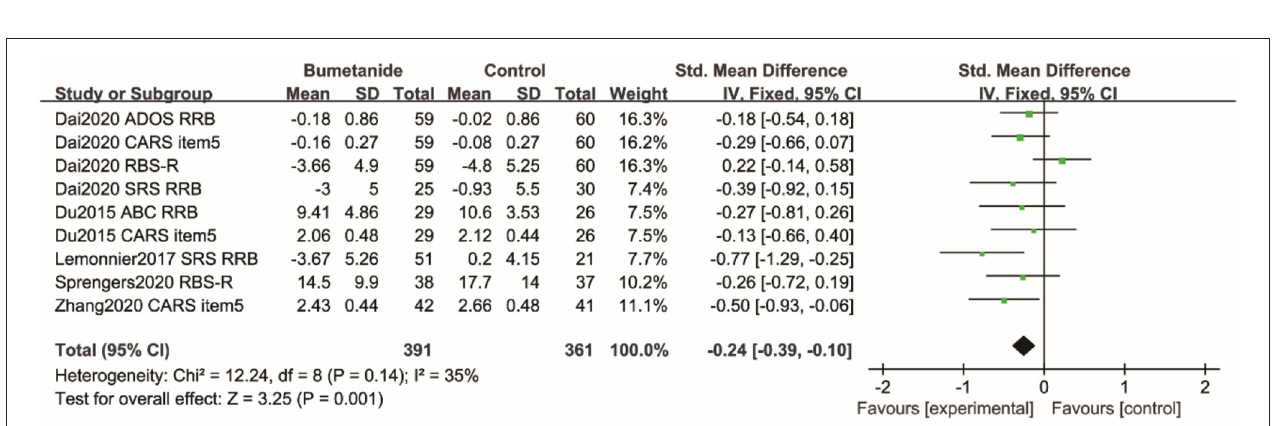
FIGURE 7 | Forest plot of the efficacy of bumetanide on RRB in children with ASD. ADOS, Autism Diagnostic Observation Schedule; RRB, Restricted, repetitive patterns of behavior, interests, or activities; CARS, Childhood Autism Rating Scale; RBS-R, Repetitive Behavior Scale-Revised; SRS, Social Responsive Scale; ABC, Autism Behavior Checklist.